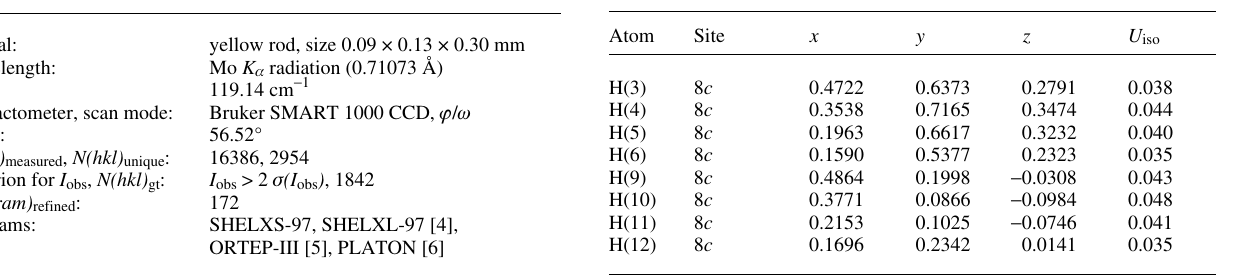
Table 2. Atomic coordinates and displacement parameters (in Å 2 ) . Table 1. Data collection and